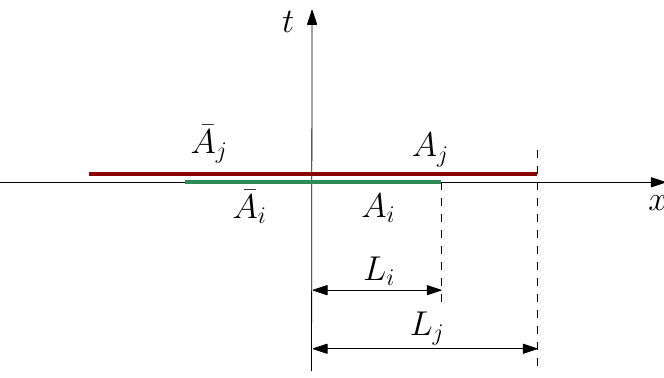
Figure 4 . Two intervals A i and A j of di(cid:11)erent lengths starting at x = 0 and their re(cid:13)ections. The union of A i with (cid:22) A j is also an interval and its length is L = L i + L j